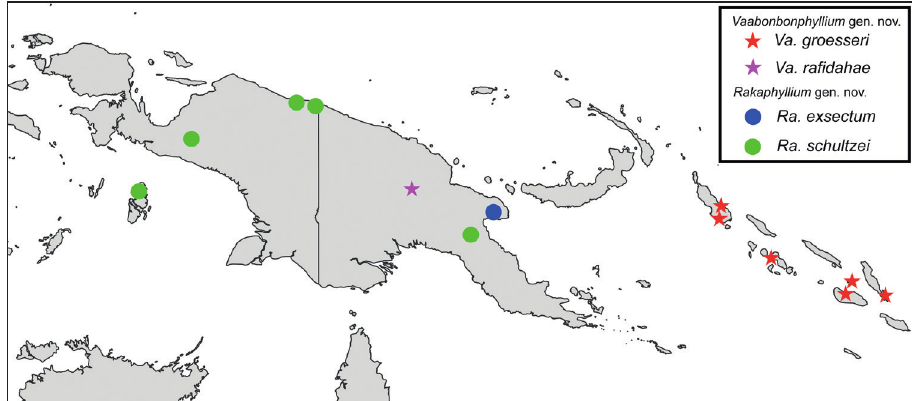
Figure 5. Distribution map noting all presently known records of Vaabonbonphyllium gen. nov. (denoted as star symbols) and Rakaphyllium gen. nov. (denoted as circle symbols) which were located and had data that could accurately be mapped. See Supplementary File 1 for full details for all records